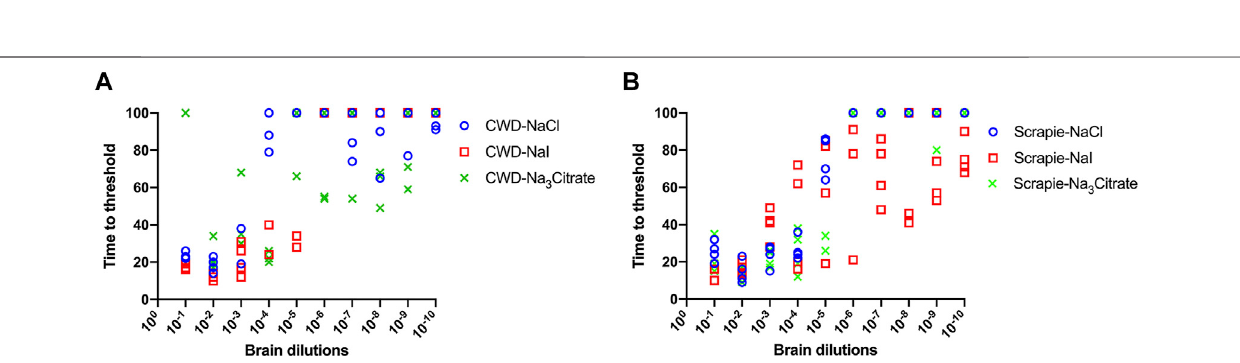
FIGURE 5 | Effect of titration of Hofmeister ions on RT-QuIC reactions seeded with CWD-positive white-tailed deer brains using bovine rPrP substrate. RT-QuIC reactions were seeded with 10 − 2 (left side of each graph) and 10 − 4 (right side of each graph) dilutions of brain homogenate from one CWD-positive and one CWD- negative white-tailed deer with the addition of 0.001% of SDS. Substrate contained bovine rPrP and Na 3 citrate (A) , Na 2 SO 4 (B) , NaCl (C) , NaI (D) , or NaClO 4 (E) . The concentration of each salt was tested at 100, 200, 300, 400, and 500 mM. Reactions were run at 42 ° C.